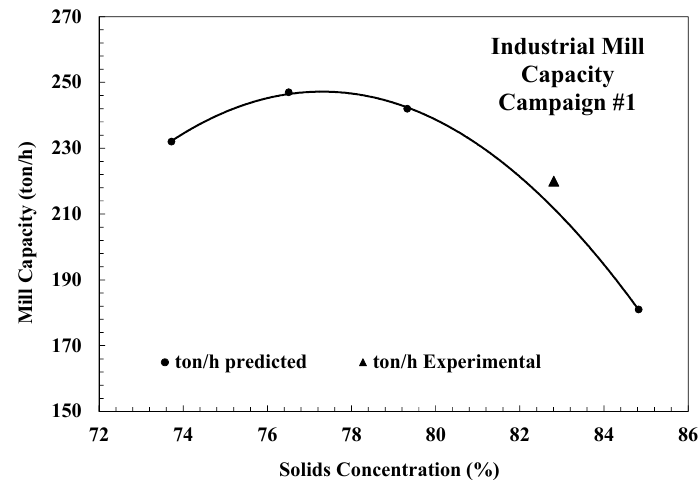
Figure 18. Predictions of industrial mill capacity (fresh feed throughput) as a function of percent solids for a product size of 40% passing 45 microns.